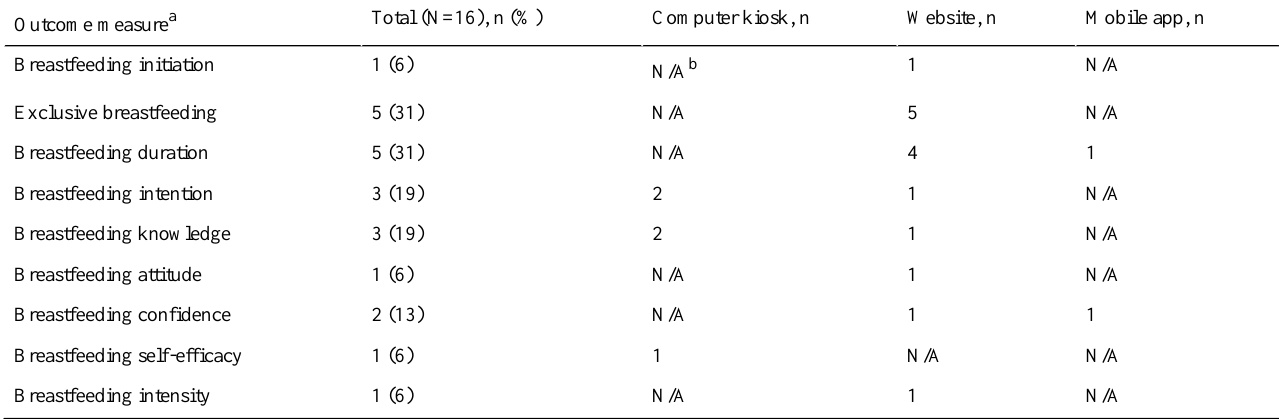
Table 4. Reported breastfeeding outcomes based on the types of internet interventions employing electronic